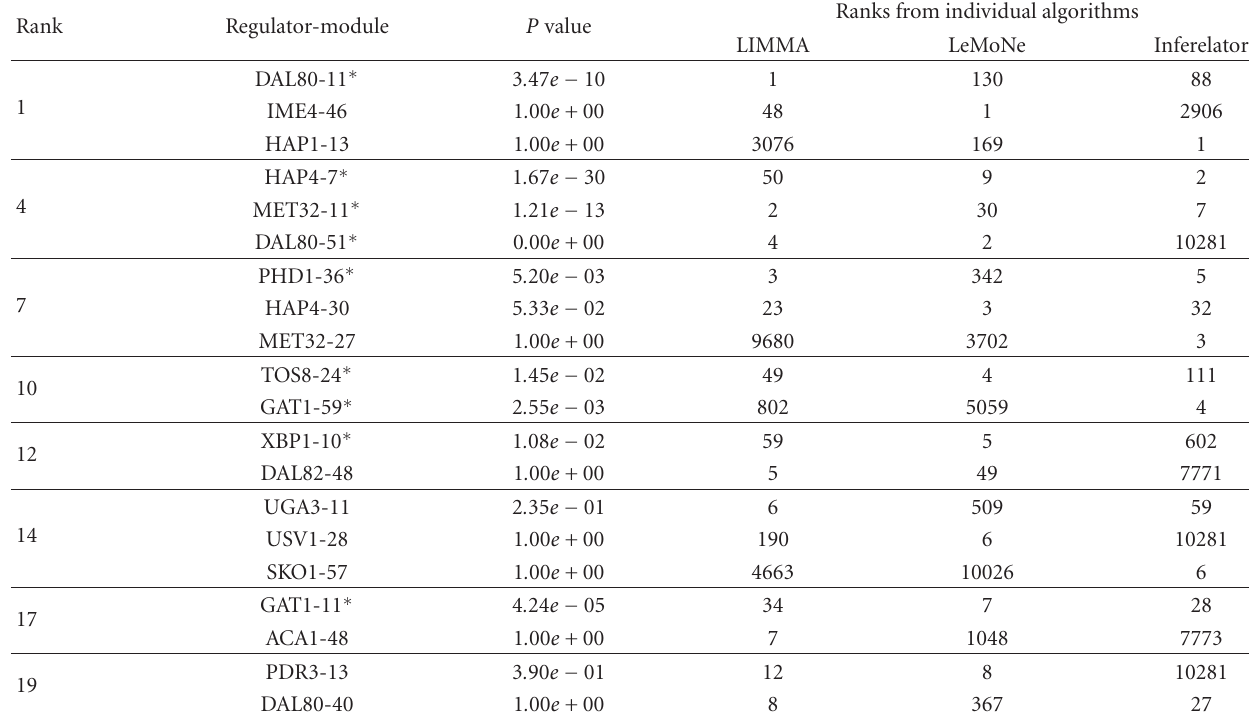
Table 1: Top twenty regulator-module interactions as given by the union method. ∗ Records represent true positives at the P value threshold of 0.05.